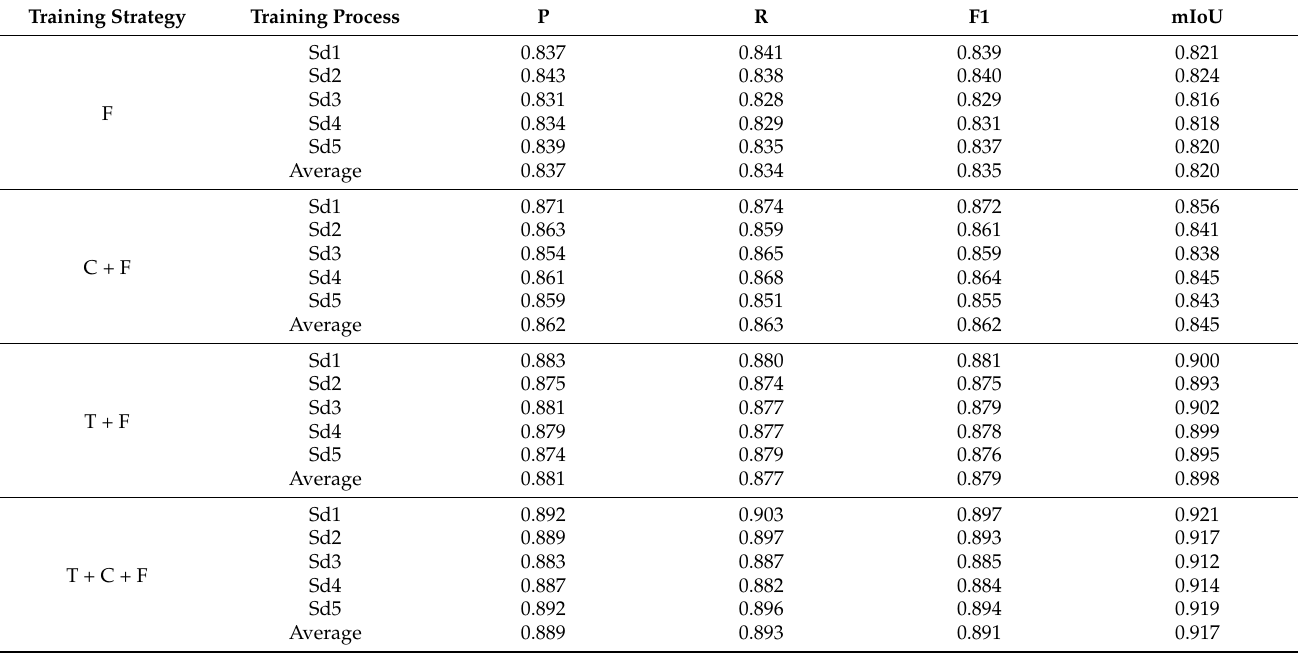
Table 2. Indicators obtained by different training strategies.